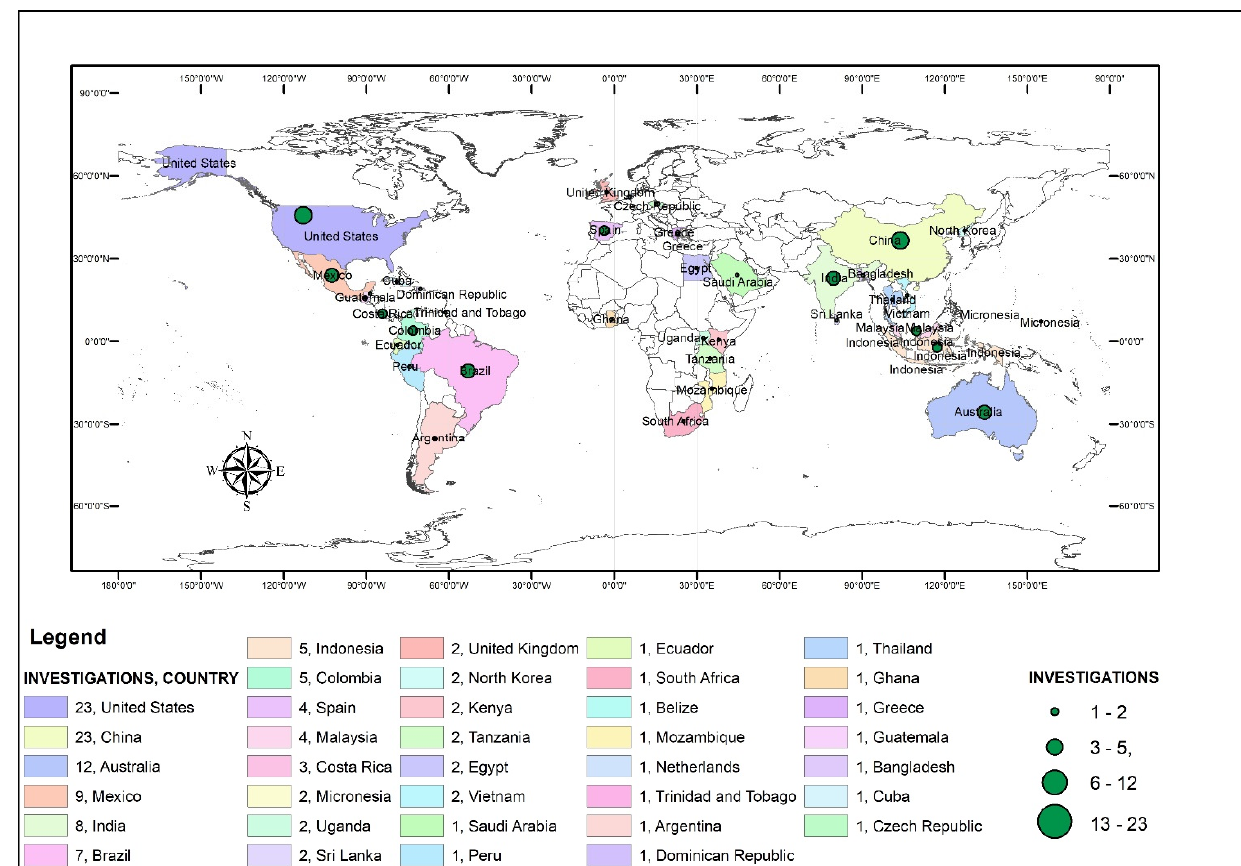
Figure 2. Number of investigations reviewed globally.